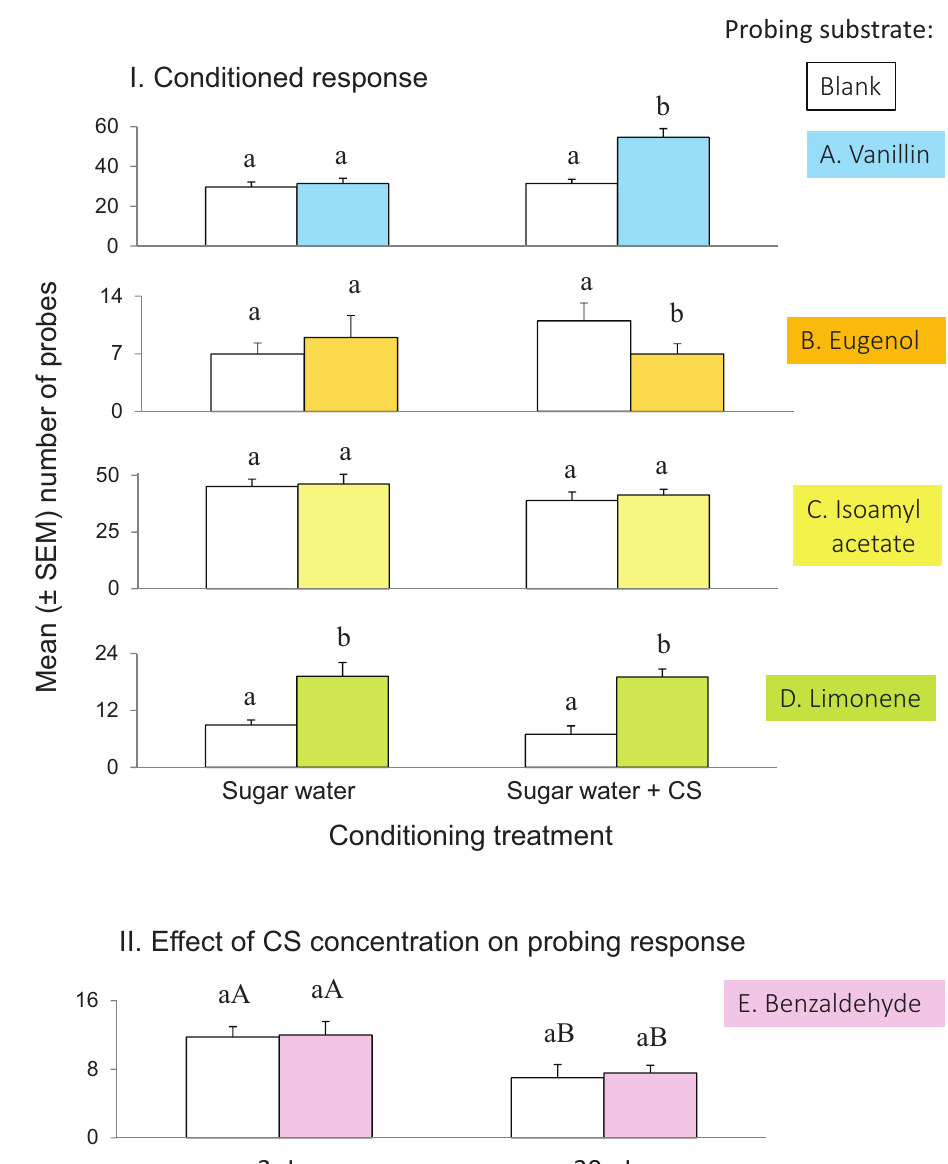
Figure 4 . Results of conditioning experiments. In I. , different letters within each conditioning treatment pair are different at p (cid:5) 0.05. In II. , upper case letters indicate significance between concentration group pairs at p (cid:5) 0.05 (t-test). Sample sizes vary by test stimulus: N = 45, anisaldehyde; N = 40 for vanillin, isoamyl acetate, and anisole; and N = 30 for limonene and eugenol.